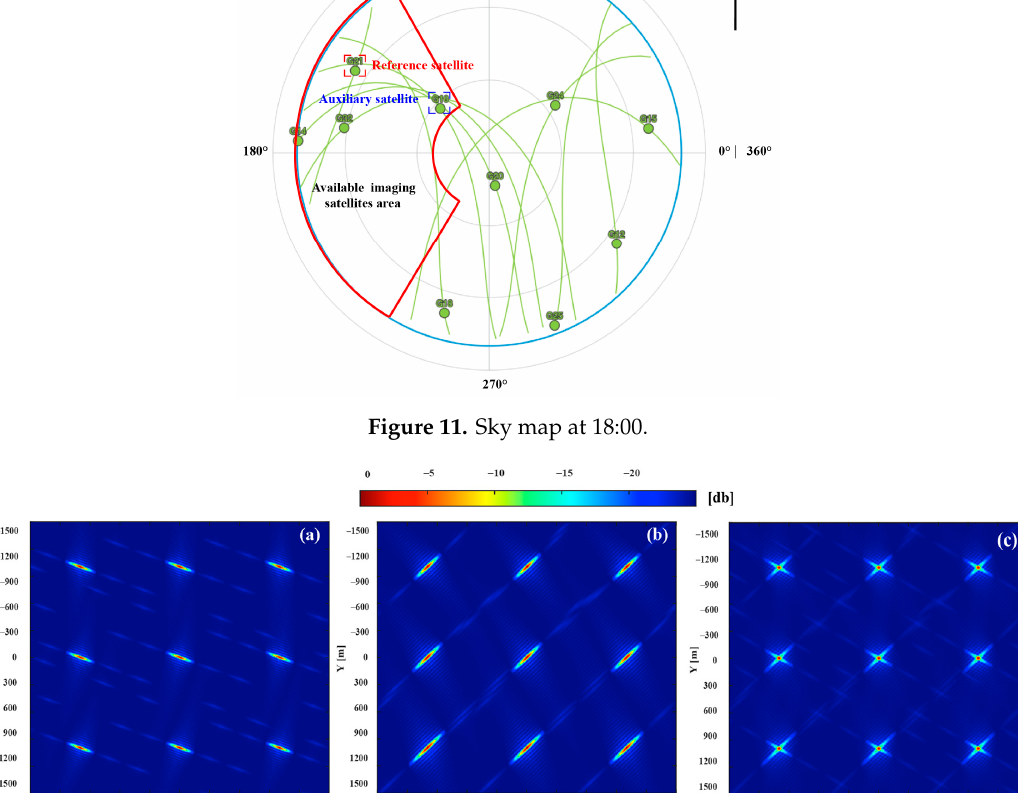
Figure 12. The imaging results: ( a ) is the imaging results of PRN21, ( b ) is the imaging results of PRN10, and ( c ) is fusion imaging results of PRN21 and PRN10.